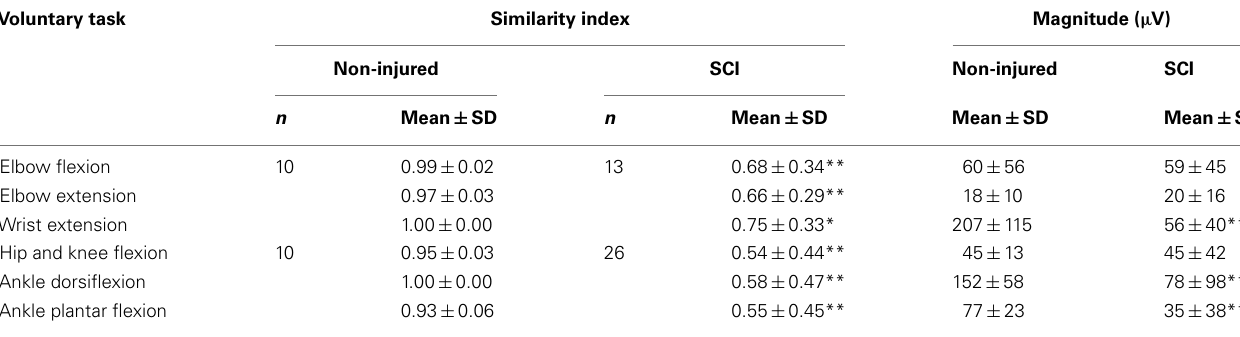
Table 3 | Group similarity index and magnitude values for non-injured ( n = 5) and SCI ( n = 13) examinations. Voluntary